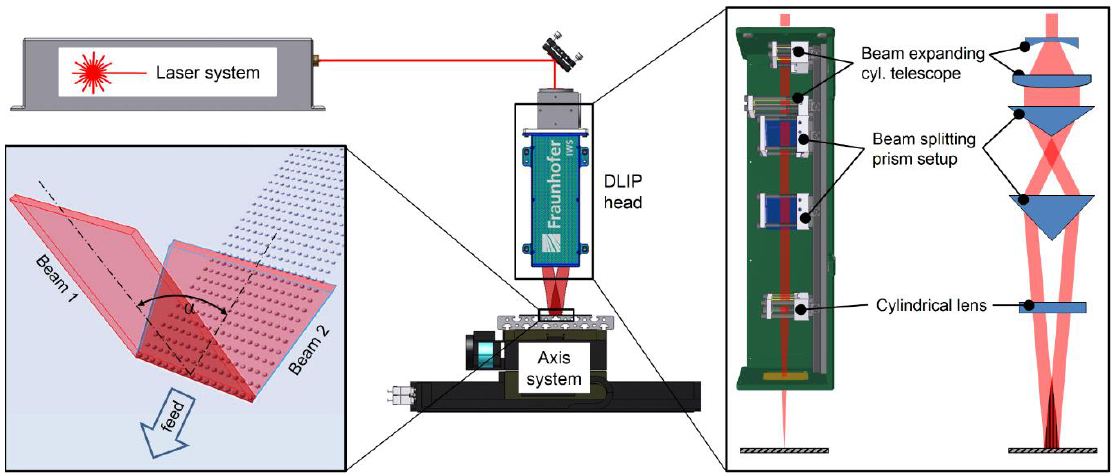
Figure 1. Modular optical assembly for high throughput direct laser interferential patterning (DLIP).